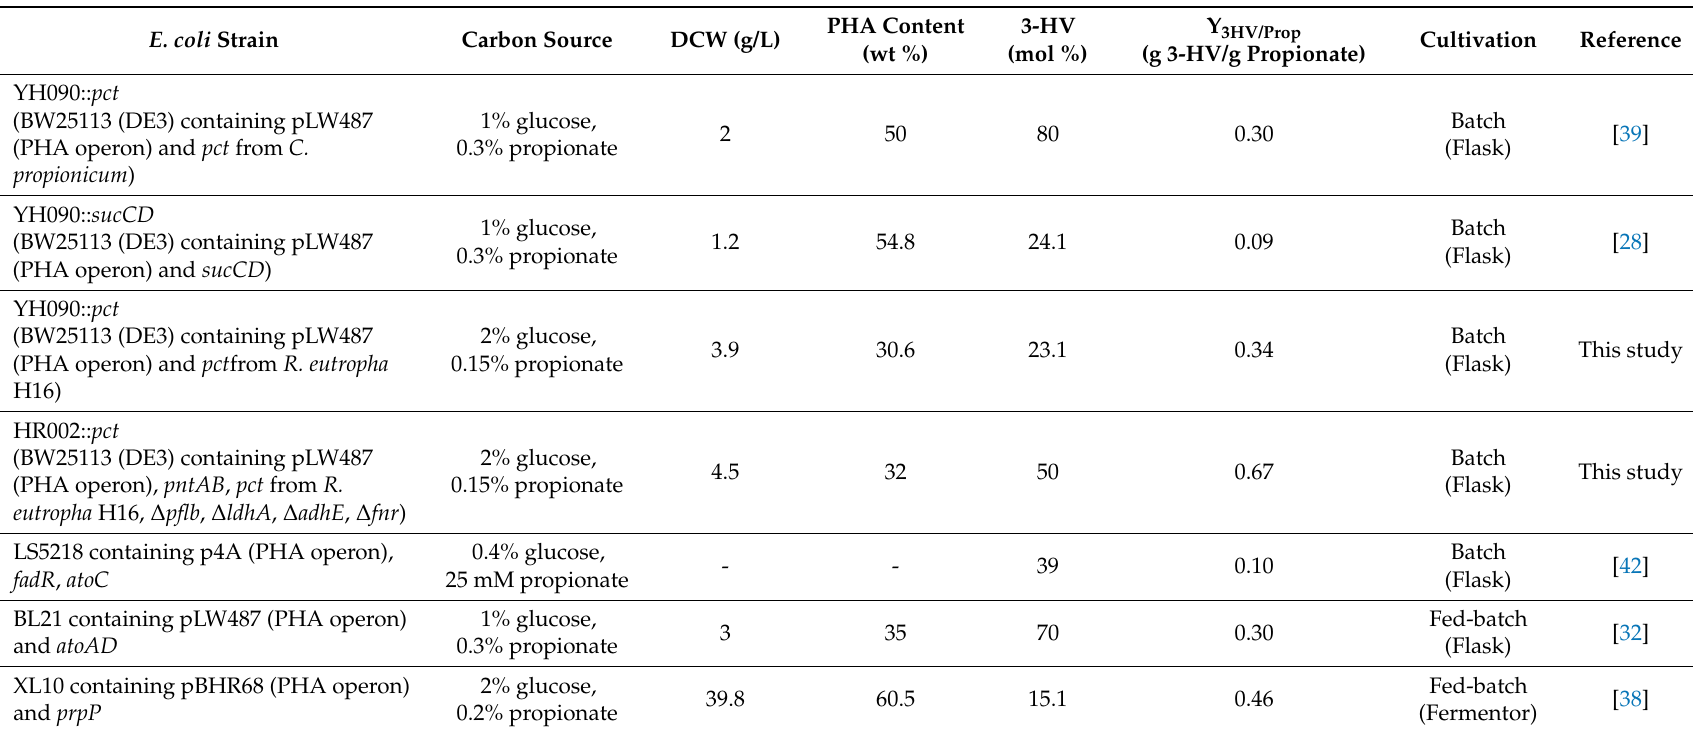
Table 2. Comparison of the reported PHBV producing E. coli